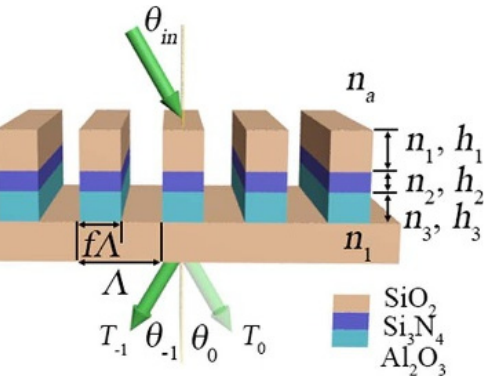
Figure 35. Schematic diagram of the three dielectric layers with a period of 1270 nm and a duty cycle of 0.58 at an incident wavelength of 1550 nm under Littrow incidence.